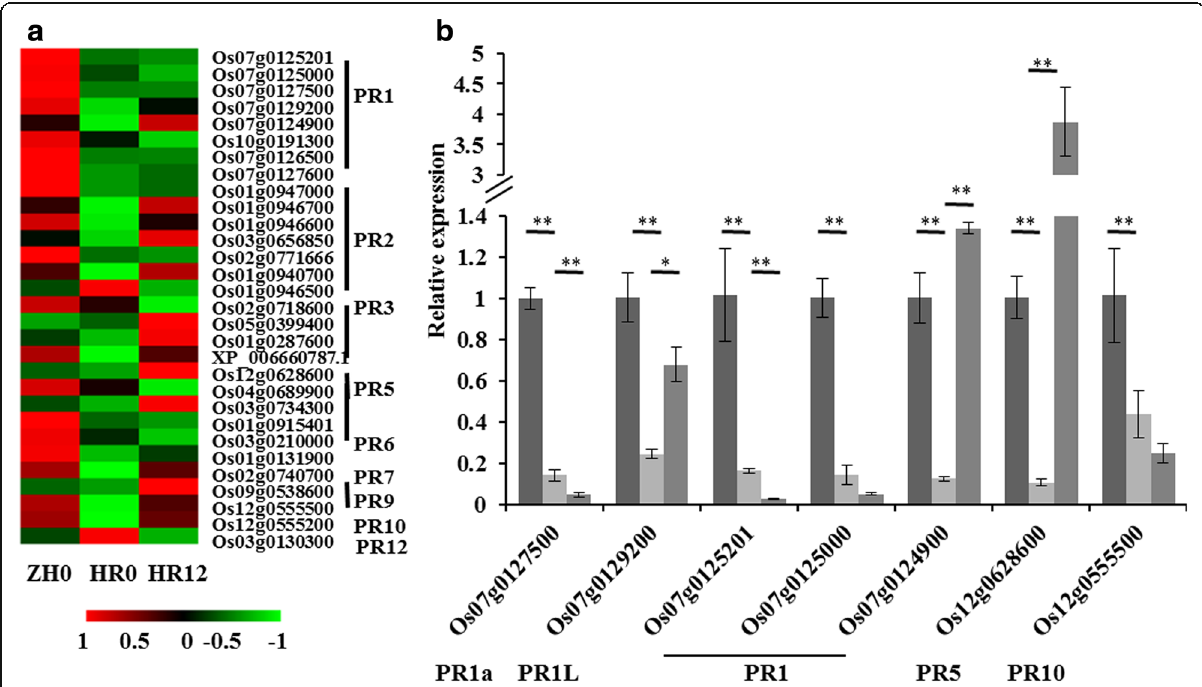
Fig. 5 Expression analysis of PR genes in HLHR plants. a Expression levels of PR transcripts in WT and HLHR plants revealed by the RNA-seq analysis. b qRT-PCR analysis of some PR genes in the HLHR-4 plants before and after BPH infestation, and in the WT ( n = 3). Asterisks in ( b ) represent significant differences determined by Student ’ s t -test at * P < 0.05 and ** P <